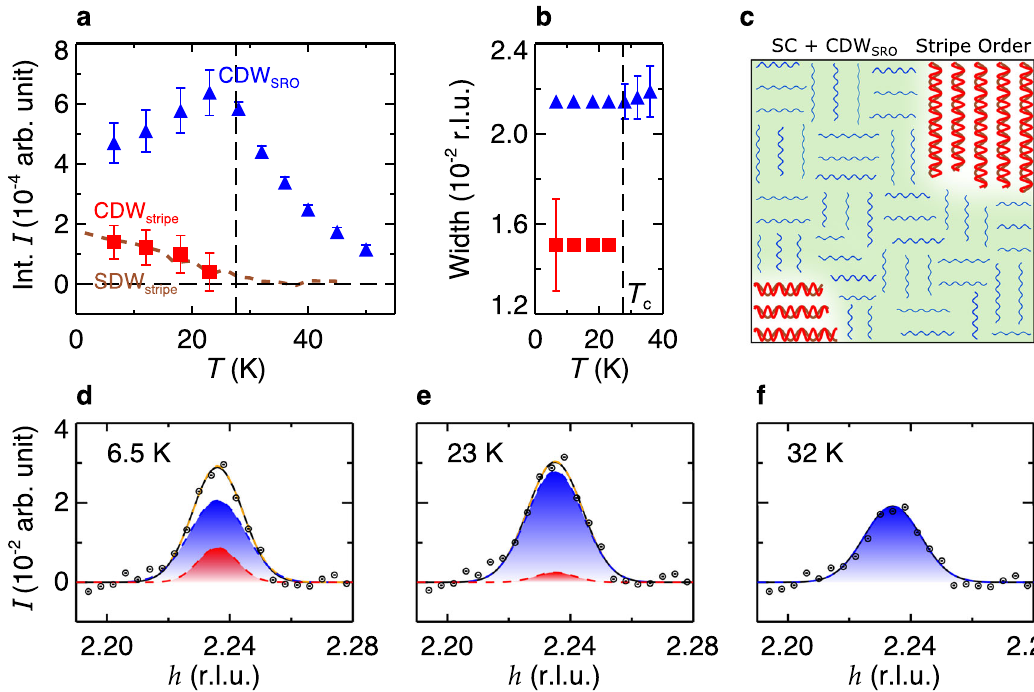
Fig. 2 | Two-component decomposition of theCDWorderinLSCO.a Integrated intensities for CDW SRO and CDW stripe extracted from the two-component fi ts. The brown dashed line shows the scaled SDW intensities measured by neutron scattering 23 . b CorrespondingpeakwidthforCDW SRO andCDW stripe .Thewidthsare fi xed for T < T c for the two-component fi ts, as described in the main text. c A pic- torialillustrationofthemixedphasesinLSCOatlowtemperatures,whichconsistof superconducting regions with suppressed CDW SRO , and separate regions